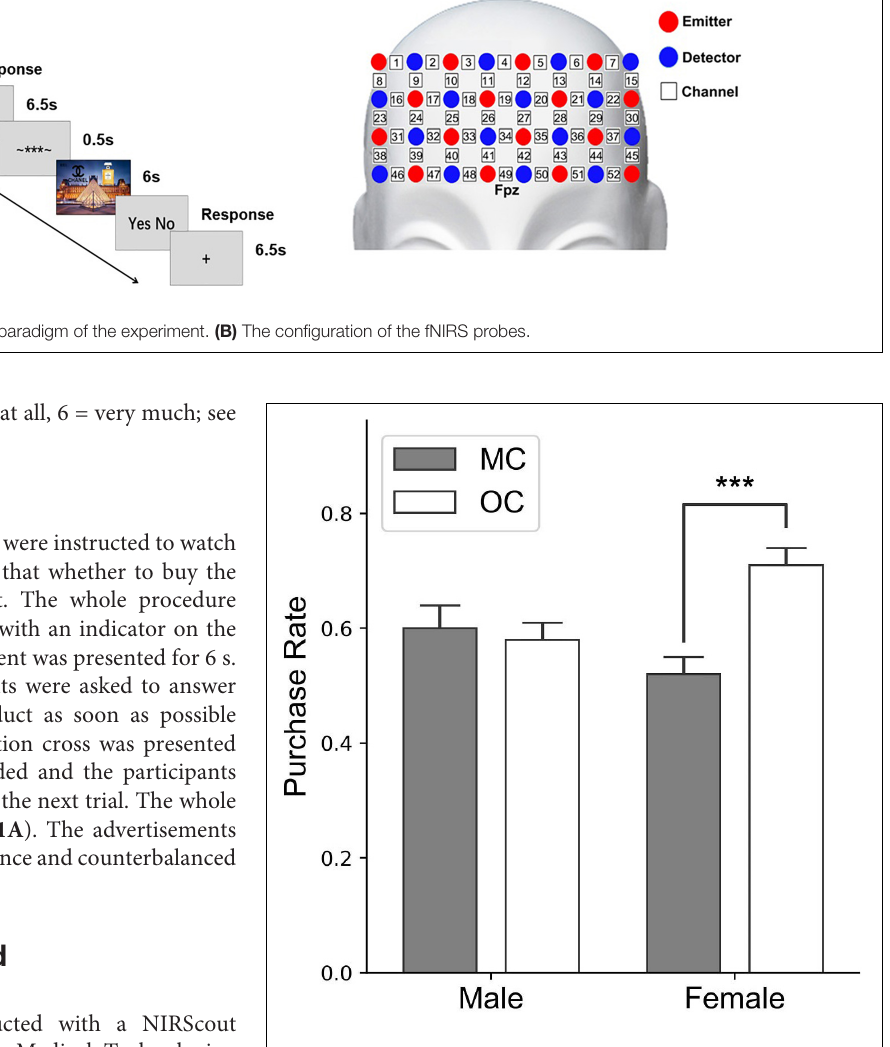
FIGURE 2 | Behavioral results. The y -axis represents the purchase rate. Error bars denote the standard error. MC: the mixed culture condition. OC: the original culture condition. ***: p <